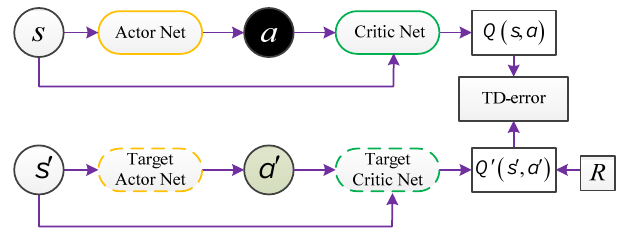
Figure 2. Transformation process in DDPG algorithm.